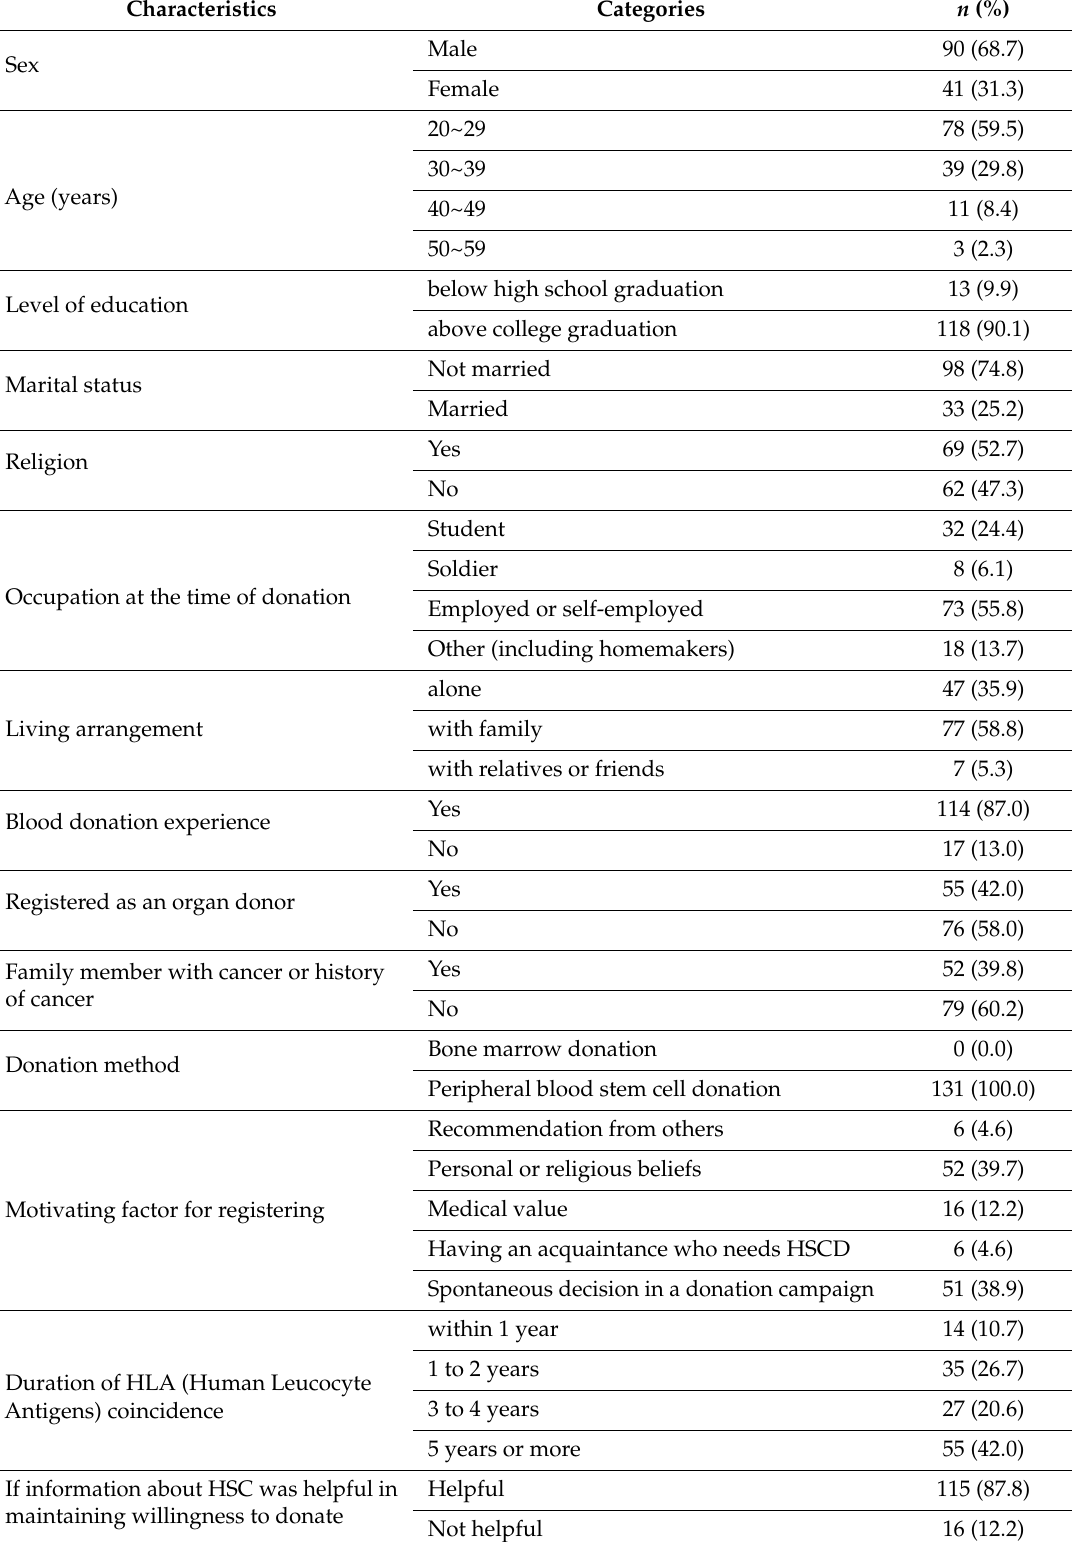
Table 1. General and HSCD (Hematopoietic Stem Cell Donation)-related characteristics of participants (N =